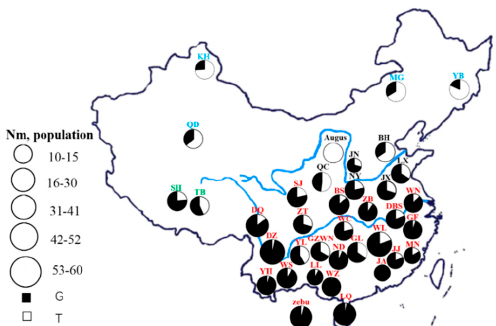
Figure 1. Geographical distribution of G and T alleles of the locus (NC_037337.1 g.35615224 T > G) of the Eukaryotic translation initiation factor 2-alpha kinase 4 ( EIF2AK4 ) gene among 37 cattle breeds in China, including 35 Chinese indigenous cattle breeds as well as Angus and pure indicine population. Circled areas are proportional to the sample size. Blue, black, red, and green fonts represent northern, central, southern, and special groups, respectively. BH, Bohai Black; BS, Bashan; DBS, Dabieshan; DZ,